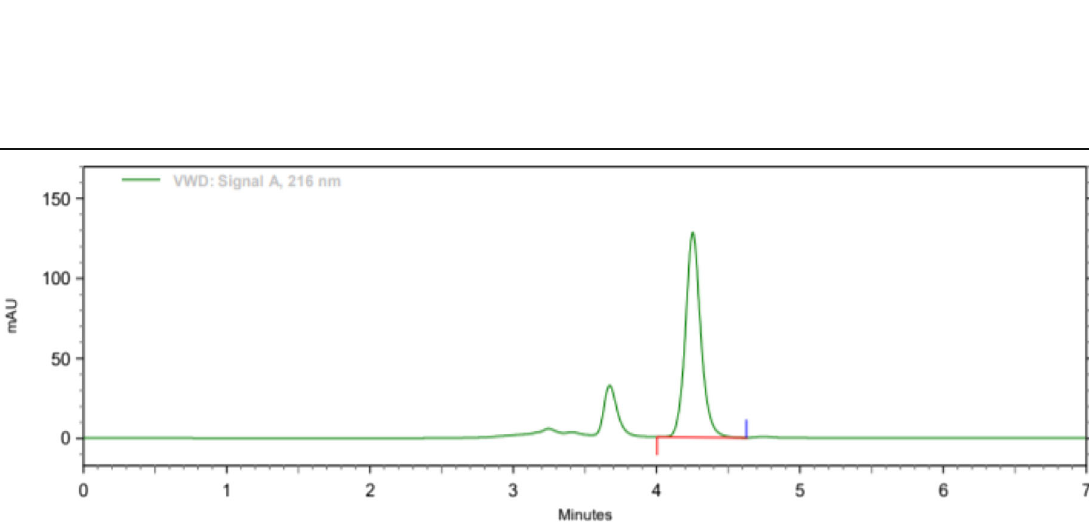
Fig. 9 Typical chromatogram of sample filtered through 0.45 μ Nylon